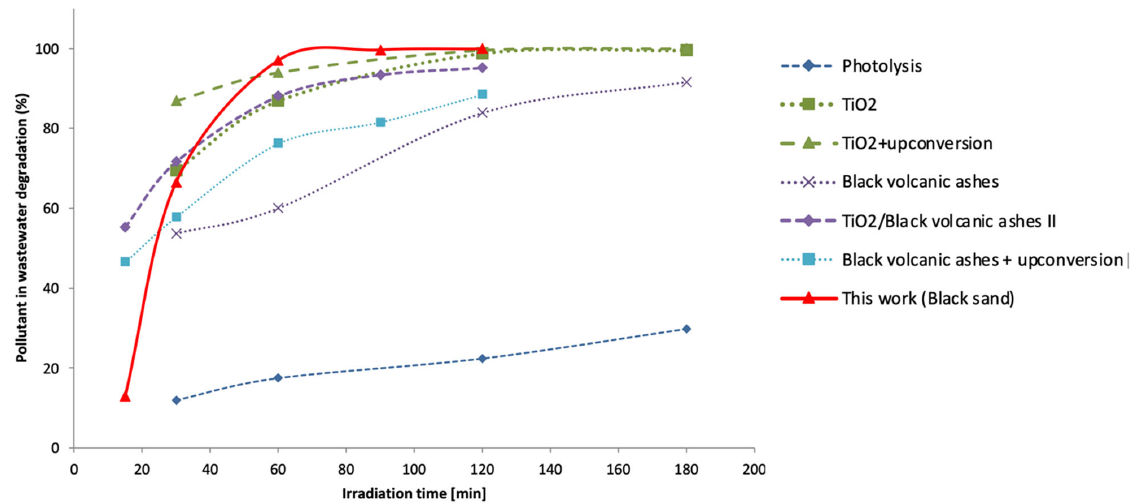
Figure 13. Photoactivity of the material studied under sunlight compared to other natural